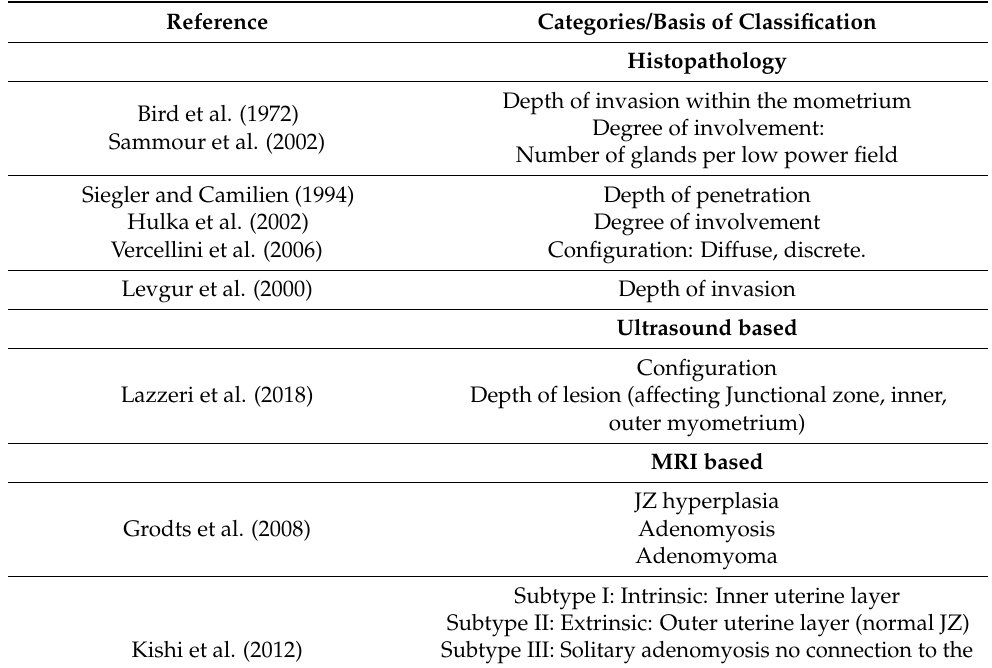
Table 2. The main features used in proposed classification systems for